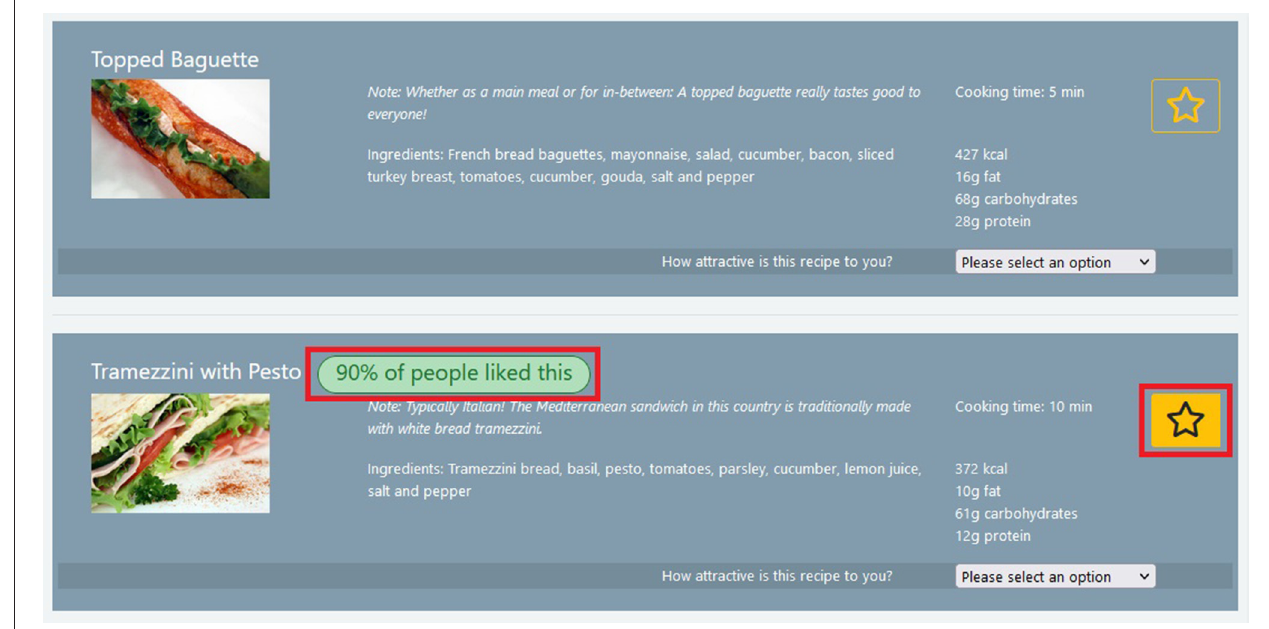
FIGURE 1 | Items as displayed to participants, showing a non-nudged item at the top and the second item below showing our implementation of the hybrid nudge. The social information and the default setting are highlighted in red in the figure for illustration purpose; the red border was not present in the UI during the study. In the final study, the images and the displayed information were extracted from allrecipes.com, and the survey was administered via custom